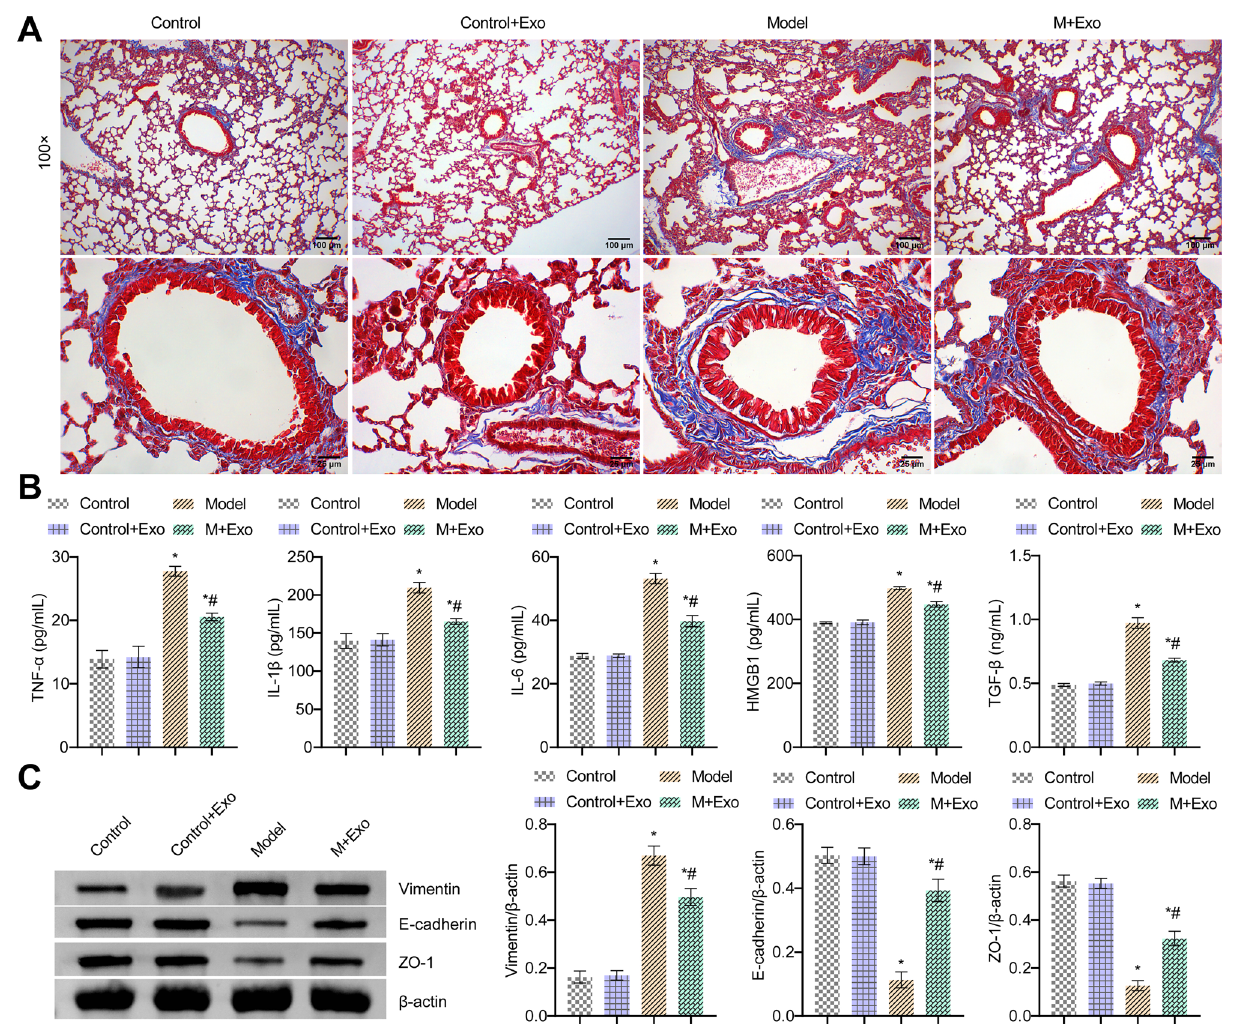
Figure 3. Exo alleviated CS-induced airway remodeling in mice. ( A ) Masson staining of the bronchus. ( B ) Expression of TNF-α, IL-1β, IL-6, HMGB1 and TGF-β in BALF were determined by ELISA. ( C ) Western blot detection of Vimentin, E-cadherin, and ZO-1 expressions. *P < 0.05 vs. Control, #P < 0.05 vs. Model. The data were presented in the form of mean ± standard deviation. n = 5